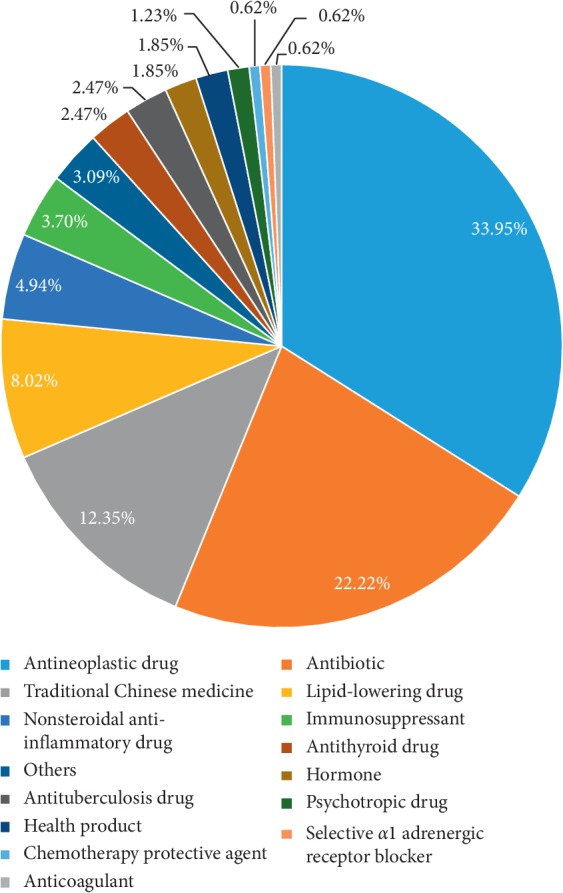
Drugs and the incidence of liver and/or kidney injury.